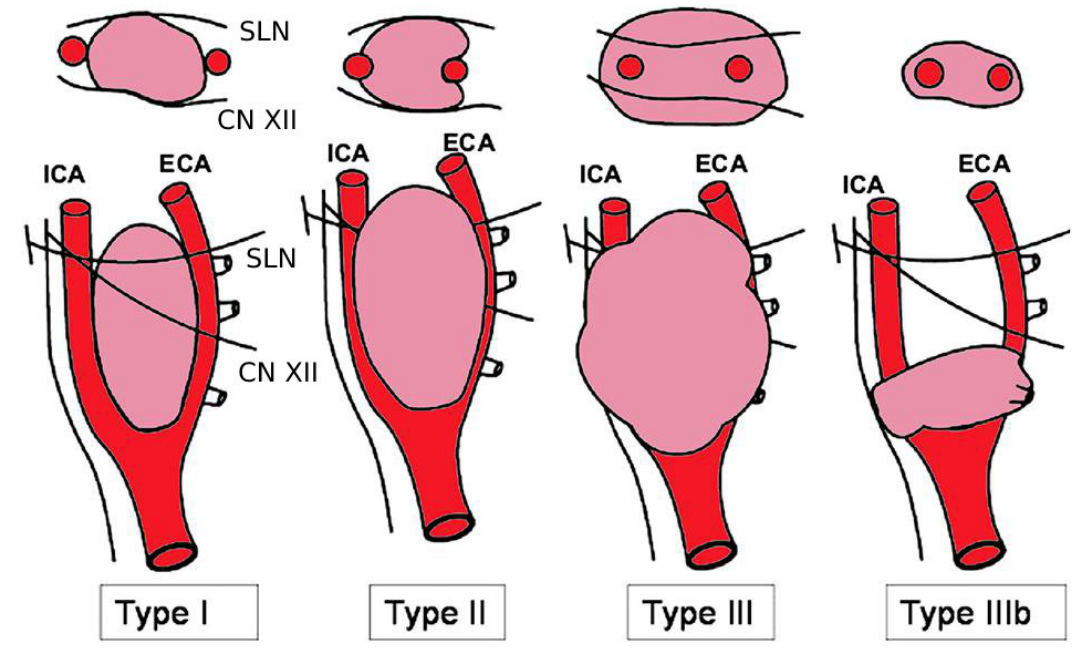
Figure 1: Shamblin classification (modified by